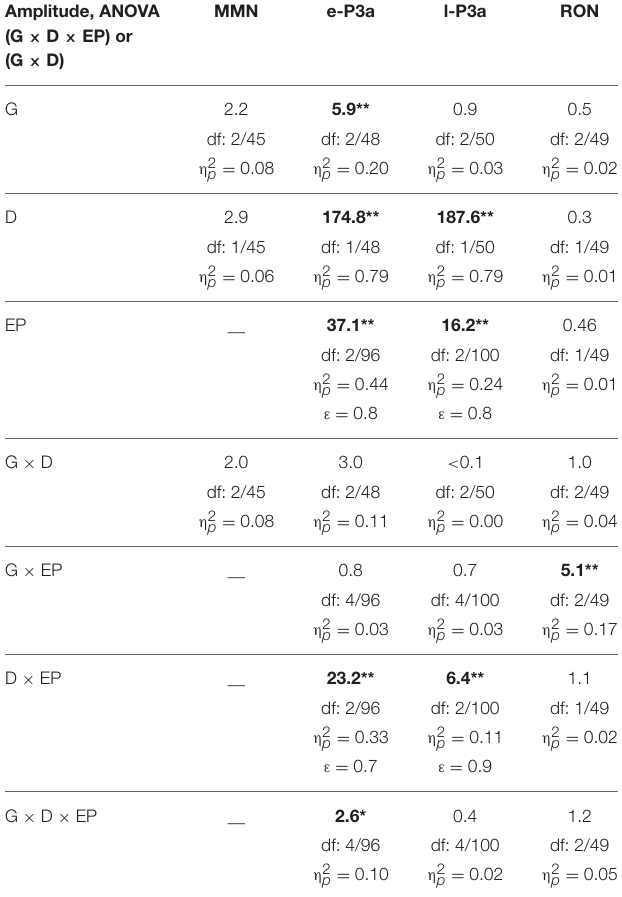
TABLE 3 | F -values from: three-factor ANOVAs (Group × Difference × Electrode Position) for e-P3a, l-P3a, and RON amplitudes, and two-factor ANOVA (Group × Difference) for MMN amplitude.